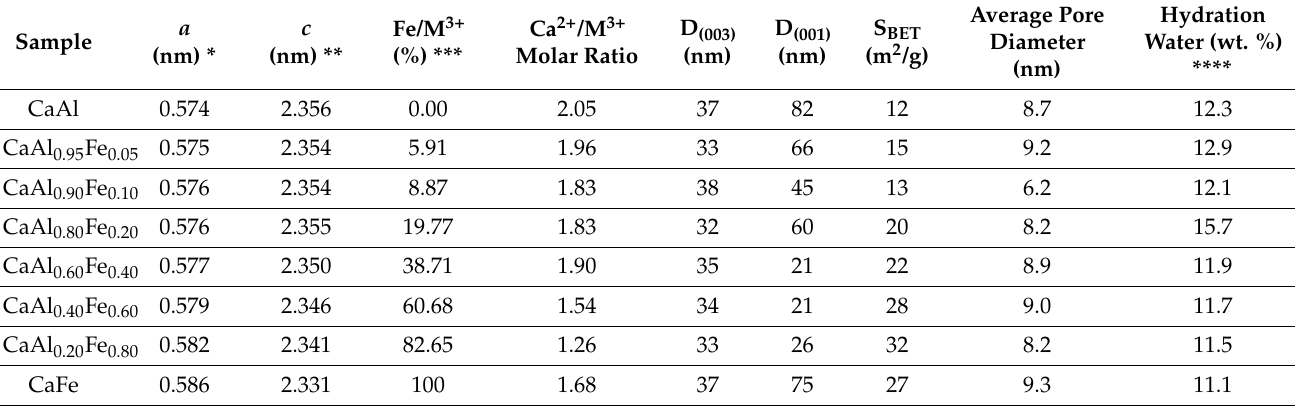
Table 1. Parameters determined for the synthesized